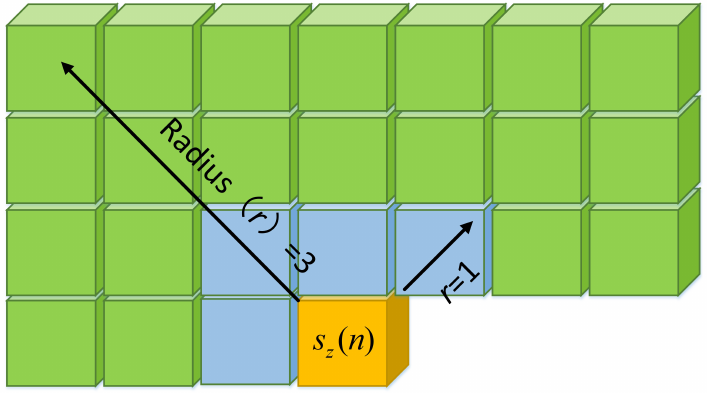
Figure 2. The context window of current